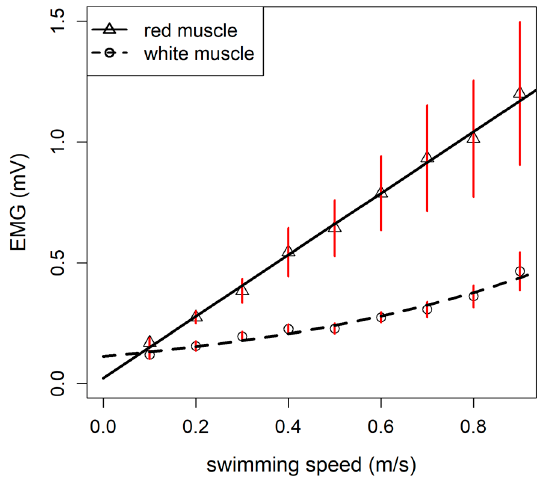
Figure 3. Linear model of the red muscle electromyogram (EMG) signal (continuous line; p < 0.05) and exponential model of the white muscle EMG signal (dashed line; p < 0.05) in rainbow trout ( Oncorhynchus mykiss ). Symbols (circles and triangles) with the red error bars indicate the mean ± standard error of the observed values, while the black continuous and dashed lines represent the red and white muscles’ EMG signals predicted by the models (see Table 2), respectively. The esti ‐ mated parameters for the red muscle’s linear model were as follows: intercept = 0.023 ± 0.010; x coefficient = 1.275 ± 0.189 (n = 10 fish; mean ± standard error). The estimated parameters for the white muscle’s exponential model were as follows: α = 0.114 ± 0.013; β = 1.497 ± 0.166 (mean ± stand ‐ ard error).